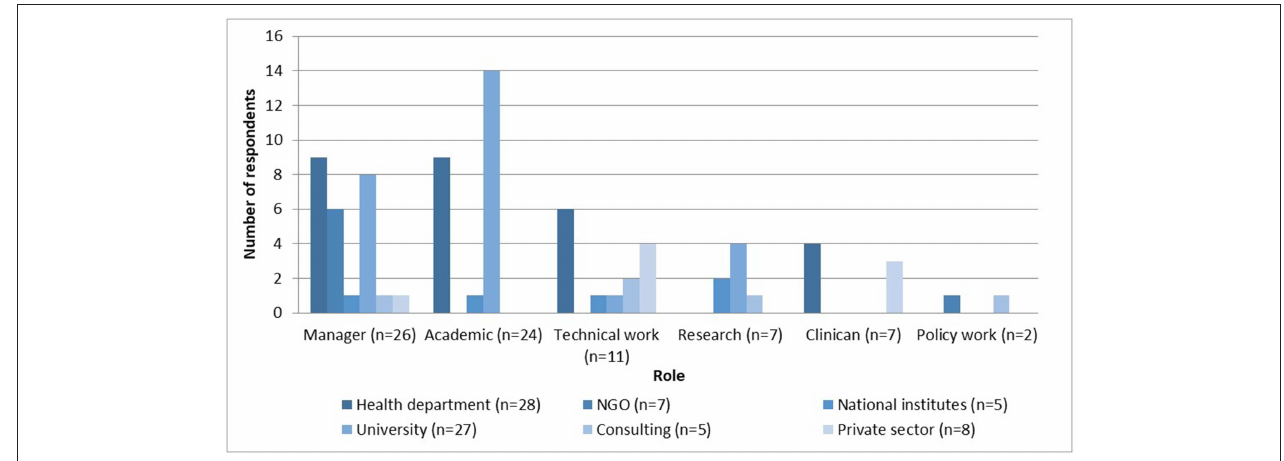
FIGURE 7 | Roles of specialists, by employers ( n =